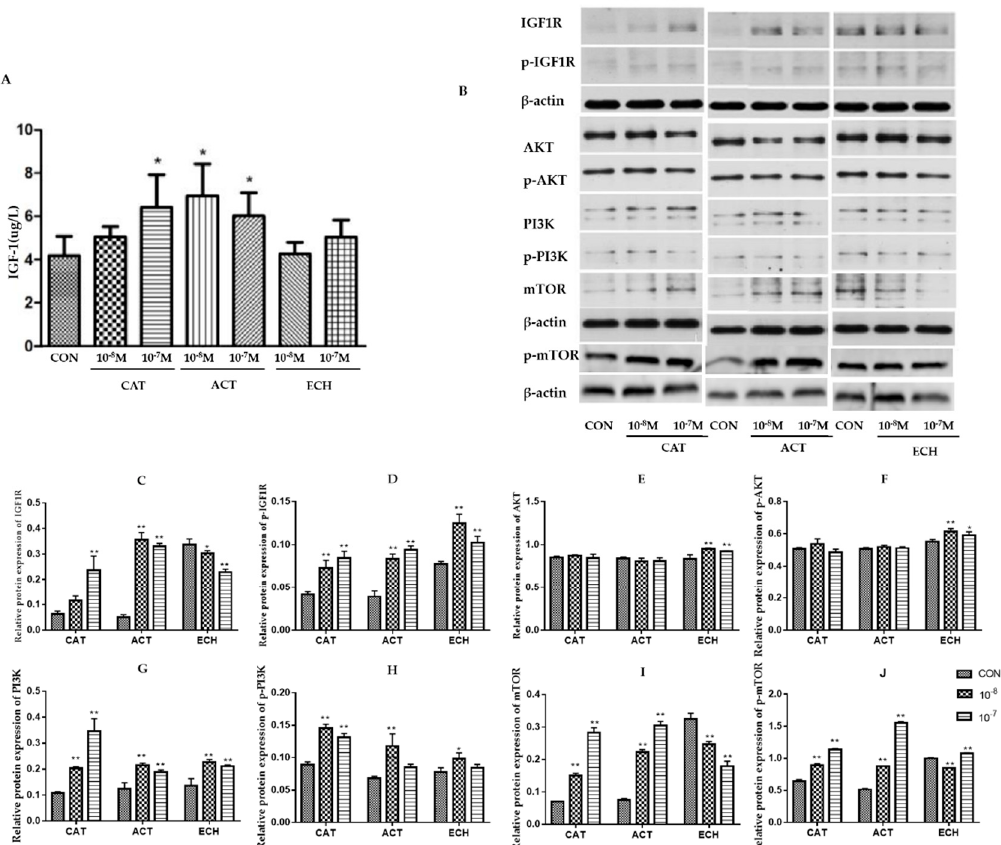
Figure 6. CAT, ACT, and ECH are involved in the regulation of IGF-1 / PI3K / mTOR pathways in osteoblastic MC3T3-E1 cells. ( A ) IGF-1 level secreted in MC3T3-E1 cells ( n = 5); ( B – J ) the expression of key proteins in IGF-1 / PI3K / mTOR pathways in MC3T3-E1 cells was analyzed by Western-blot method ( n = 3). All data are expressed as the mean ± SD, * p < 0.05 and ** p < 0.01 as compared with the control group.